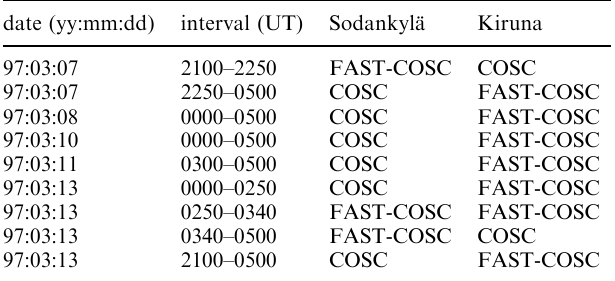
Table 3. Operations of the FAST-COSC